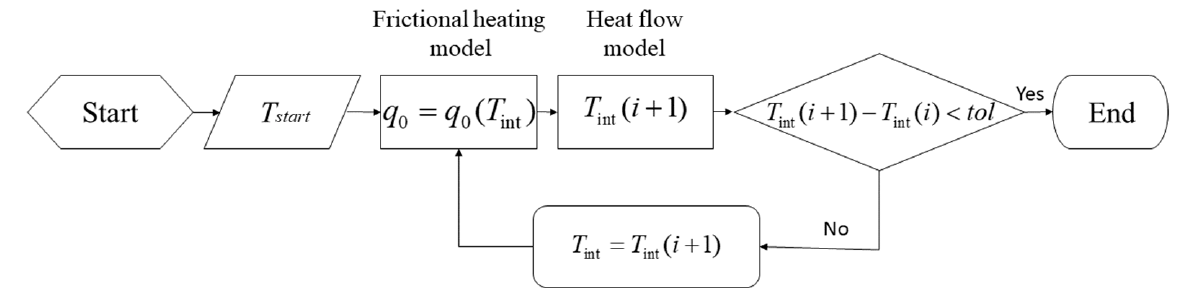
Figure 5. Flowchart showing the steps involved in calculating the interface temperature at position r ∗ = r sh using the coupled heat flow and frictional heating models.